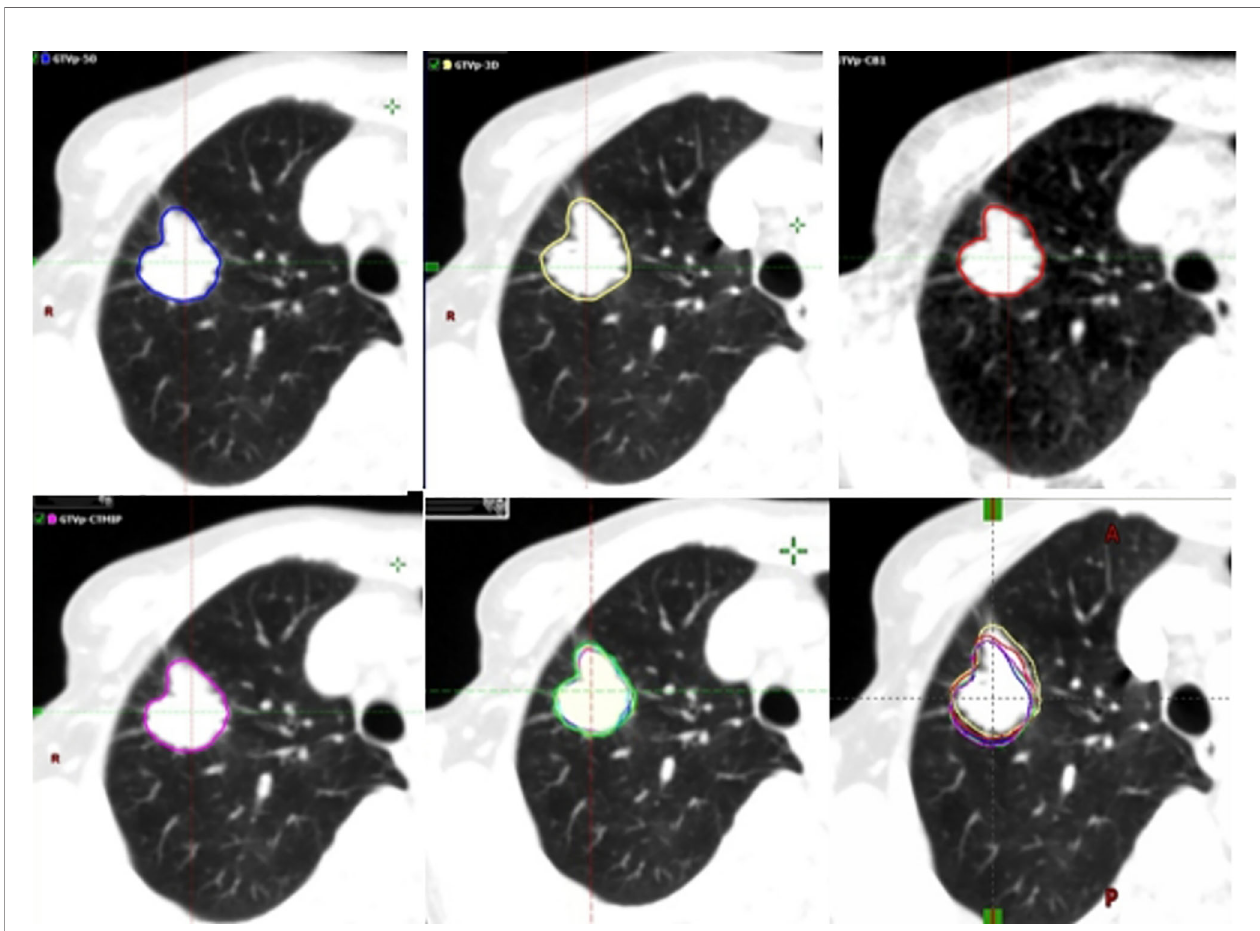
FIGURE 1 | Example (Tumor 132) of the different target volumes. GTV (blue line) contoured based on the end-exhalation of 4DCT, GTV (yellow line) based on 3DCT, GTV (red line) based on CBCT, GTV (magenta line) based on 4DCT MIP, and GTV (green line) derived from ten phases of 4DCT. 3DCT, three-dimensional computed tomography; 4DCT, four-dimensional computed tomography; CBCT, cone-beam computed tomography; GTV, gross tumor volumes; MIP, maximum intensity